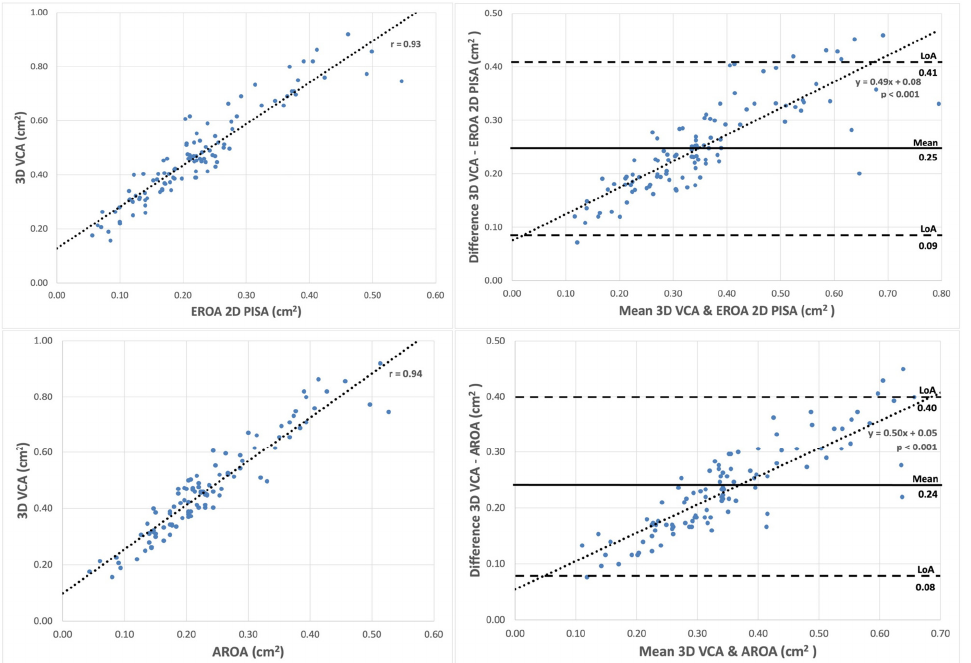
Figure 6. Correlations ( left ) and Bland–Altman plot ( right ) for 3D VCA. Correlation ( upper left ) and Bland–Altman plot ( upper right ) of 3D VCA compared to EROA 2D PISA. Correlation ( lower left ) and Bland–Altman plot ( lower right ) in comparison with AROA. Correlation plots with pairs of value using two methods. Bland–Altman plots with differences of two methods plotted against the mean values of the same methods (right). Dotted lines = fitting line of linear regression, solid lines = mean differences of two methods, dashed lines = limits of agreement (LoA). Abbreviations: 2D = two-dimensional; 3D = three-dimensional; EROA = effective regurgitation area; PISA = proximal isovelocity surface area; VCA = vena contracta area, AROA = anatomic regurgitation orifice area.